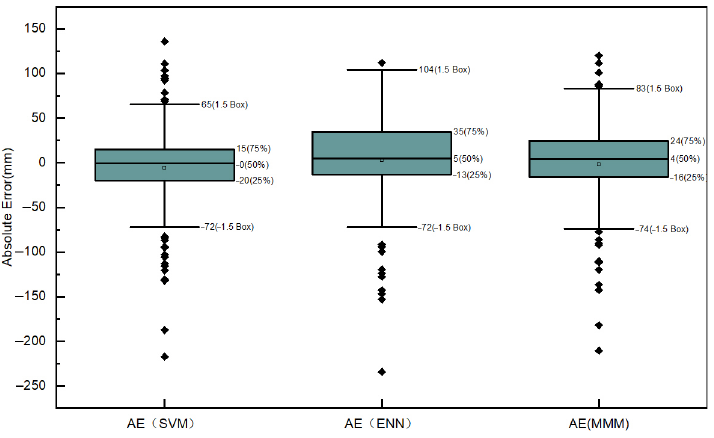
Figure 11. Box plot of Absolute Errors.